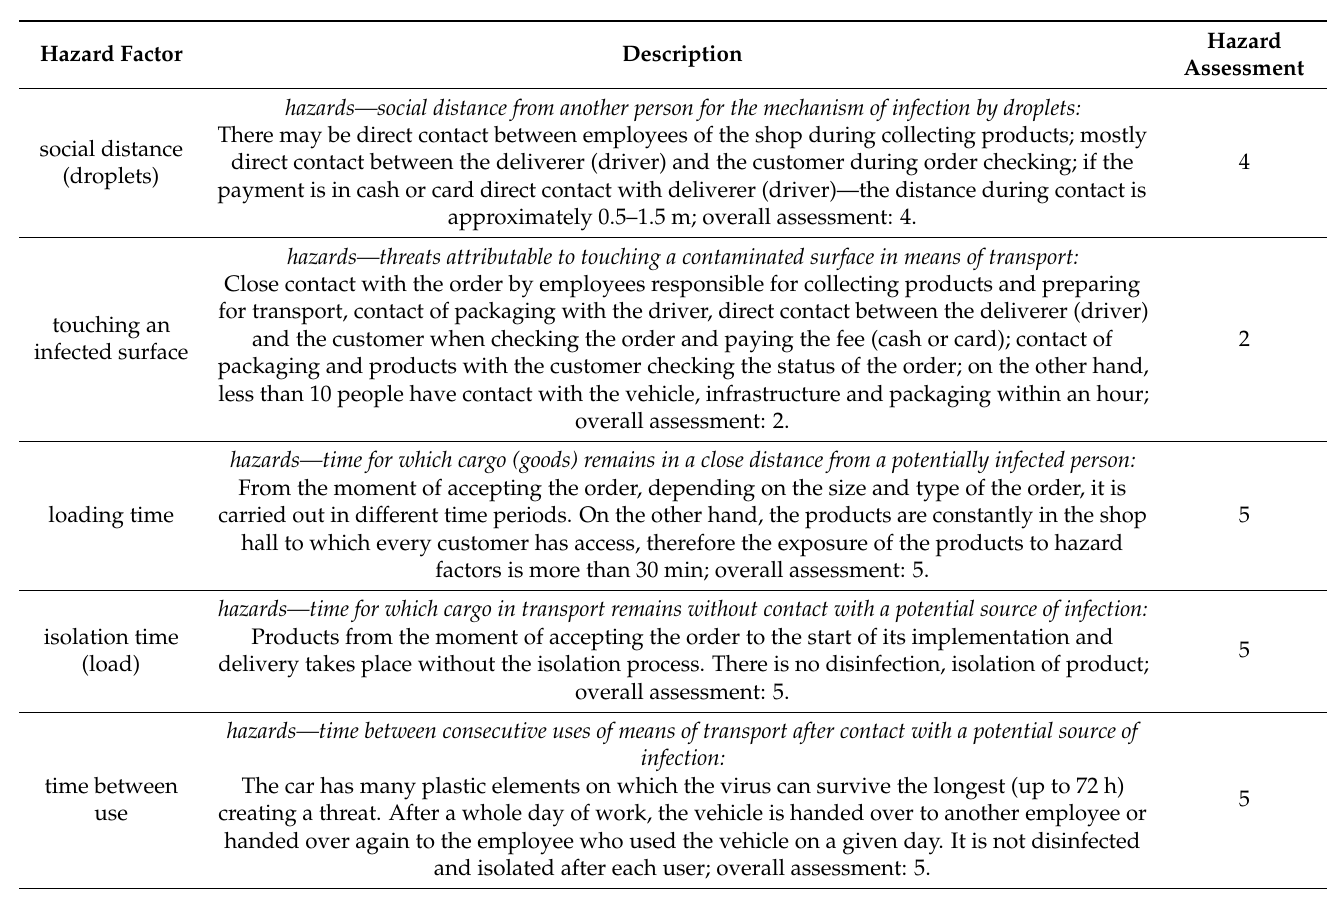
Table 6. Assessment of epidemic hazards due to criteria of the DHI methodology—shopping